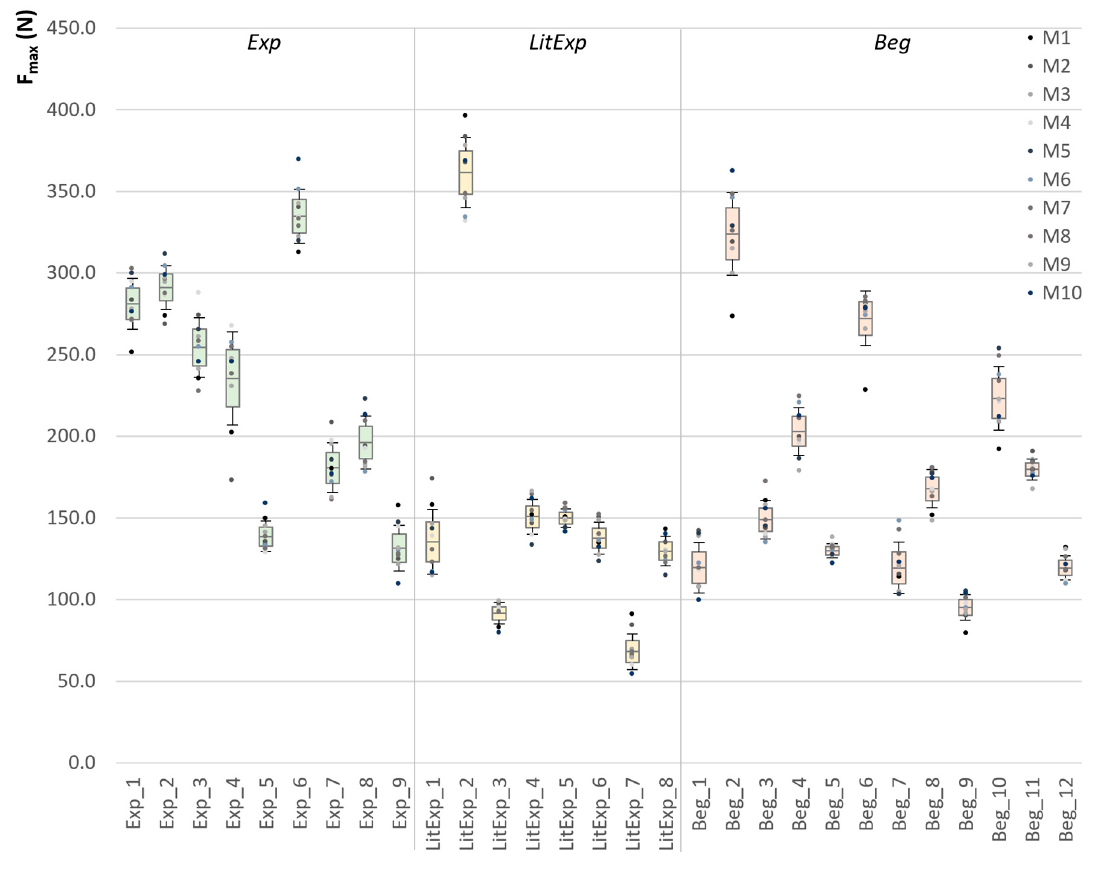
Figure 6. Overview of F max of the repeated trials for each tester. Displayed are the arithmetic means (M), 95%-confidence intervals (CI) and standard deviations (SD; error bars) of the F max (N) of the 10 trials of each tester sorted into the groups experienced (Exp; green, n = 9), little experienced (LitExp; yellow, n = 8) and beginners (Beg; orange, n = 12). The analysis of variance for repeated measurements (ANOVA RM) are significant for Beg ( p = 0.039) and LitExp ( p = 0.033), not for Exp ( p > 0.05).